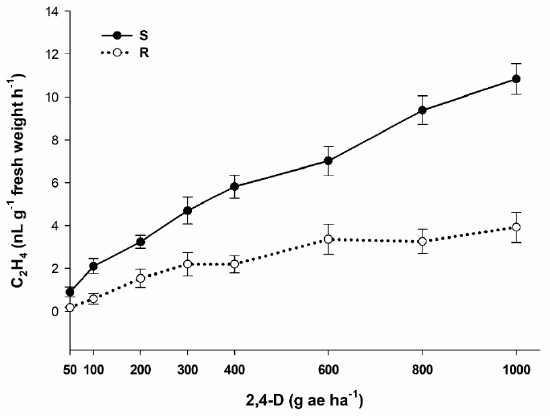
Figure 3. Accumulation of ethylene (C 2 H 4 ) following the application of the herbicide 2,4-D in populations of C. acanthoides . Vertical bars represent the standard error of the mean ( n = 4).